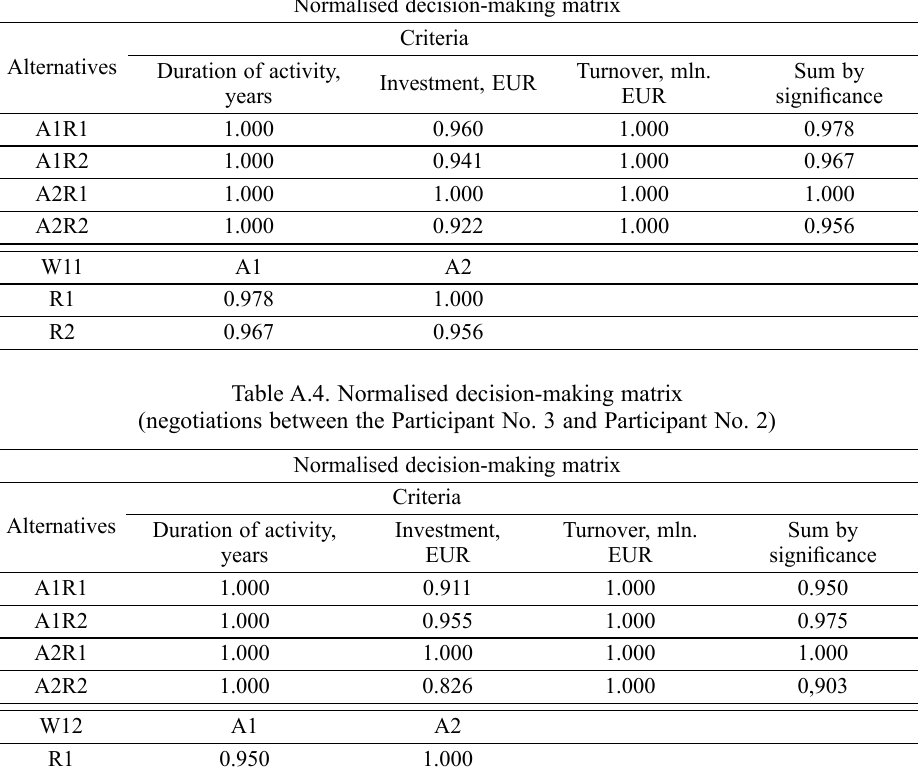
Table A.3. Normalised decision-making matrix (negotiations between the Participant No. 1 and Participant No. 2)